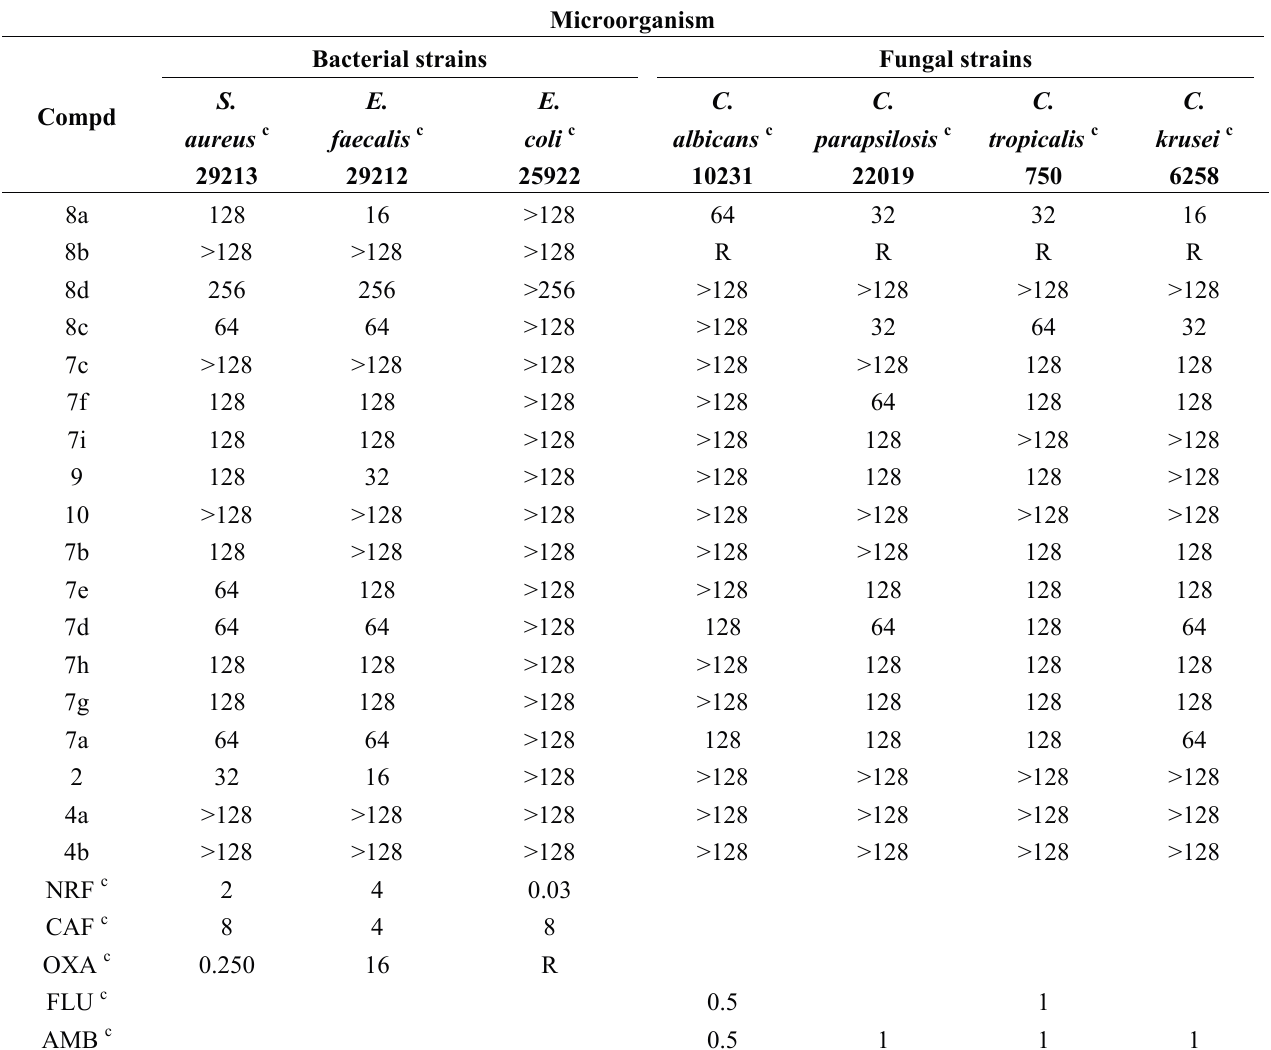
Table 2. Antimicrobial activity results a, b of functionalized aziridines derivatives 2 , 4a , b , 7a – i , 8a – d , 9 , 10 (MIC in